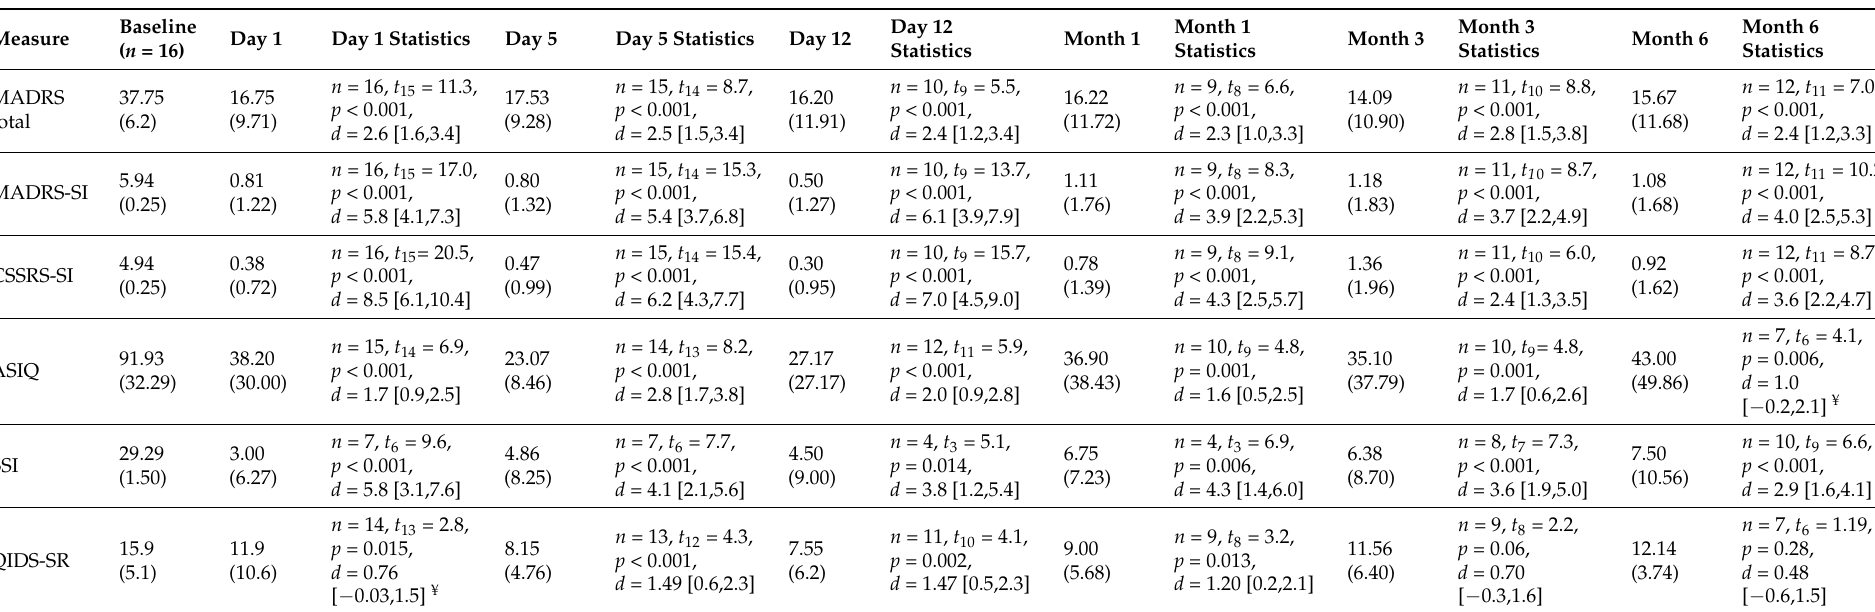
Table 3. Paired t-test results and effect sizes (Cohen’s d) for continuous measures of depression and suicidal ideation, relative to baseline, within the ketamine-treated sample ( n =